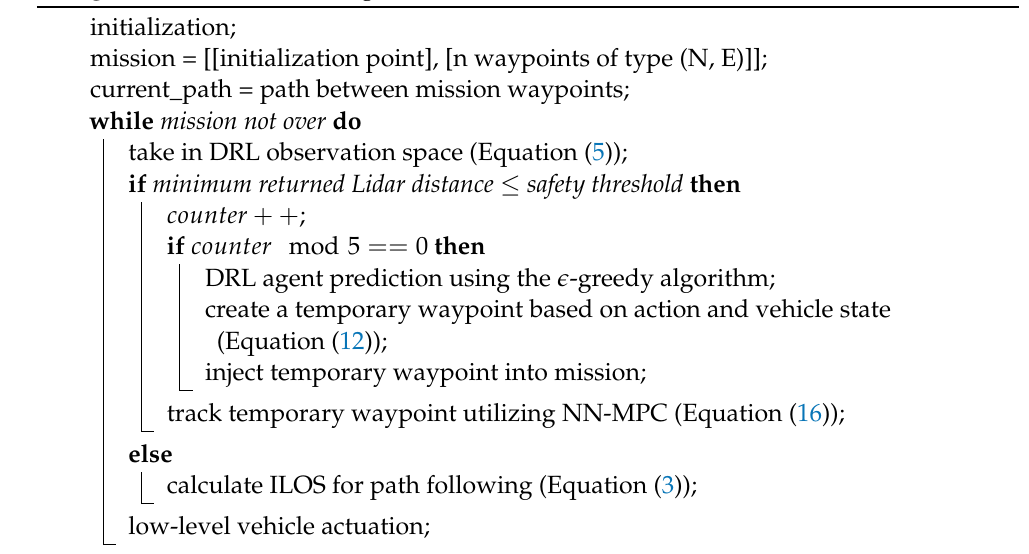
Algorithm 1: DRL Path Augmentation for Obstacle